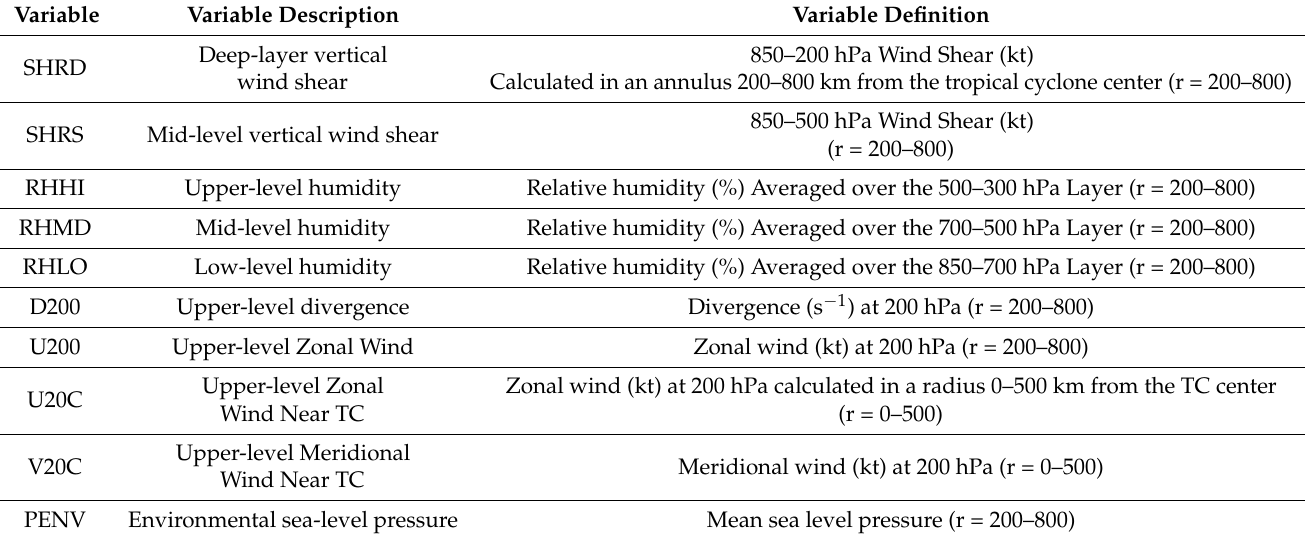
Table 1. Large-Scale Environmental Variables Calculated From the HAFS Ensemble